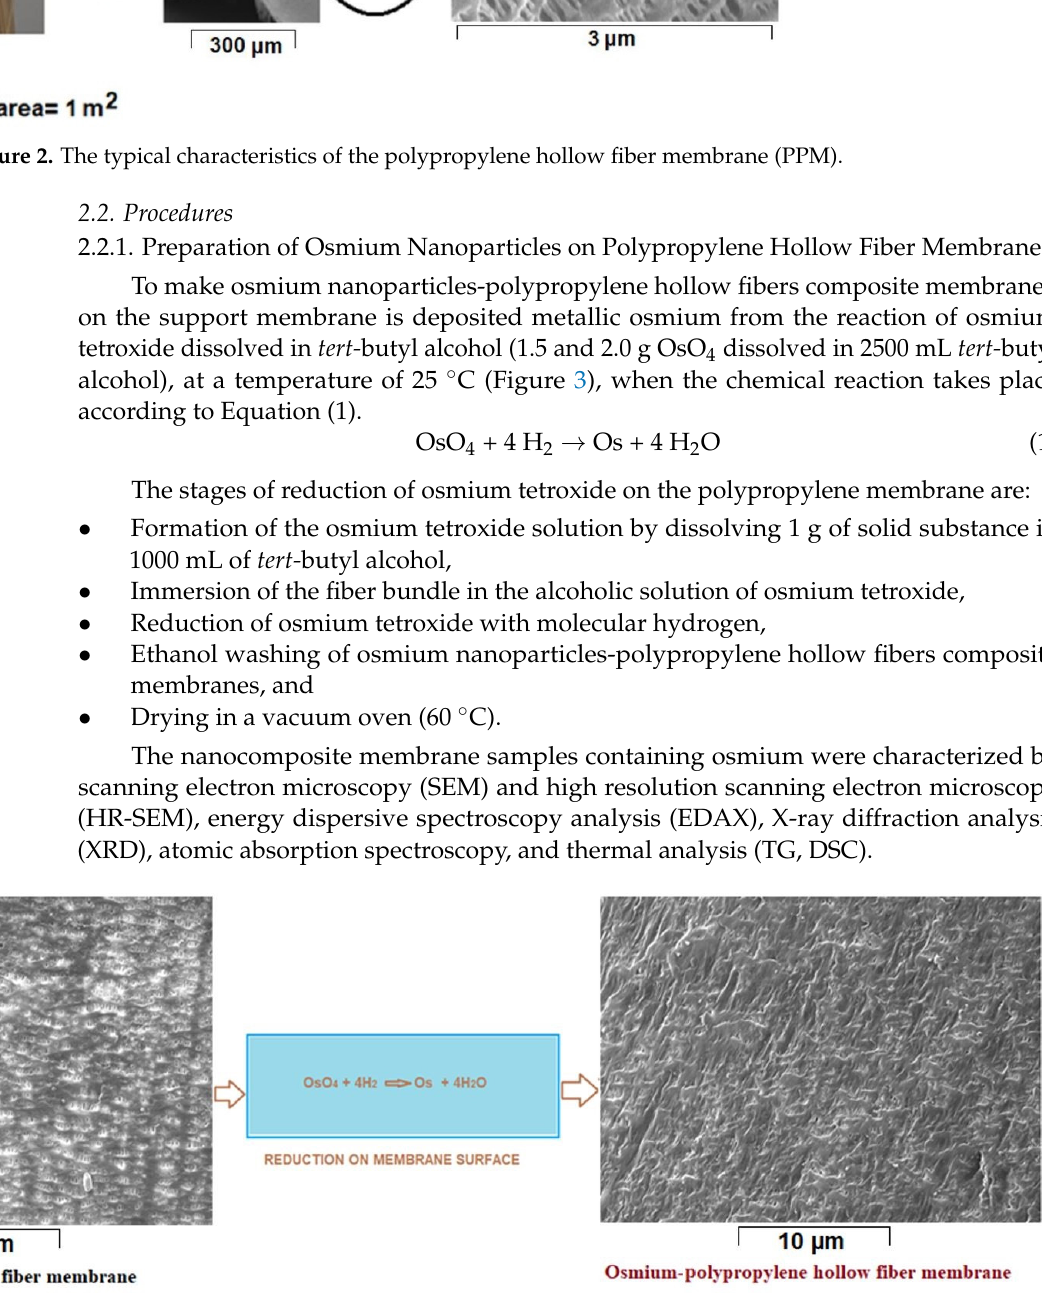
Figure 3. Obtaining osmium nanoparticles on polypropylene hollow fiber membrane.